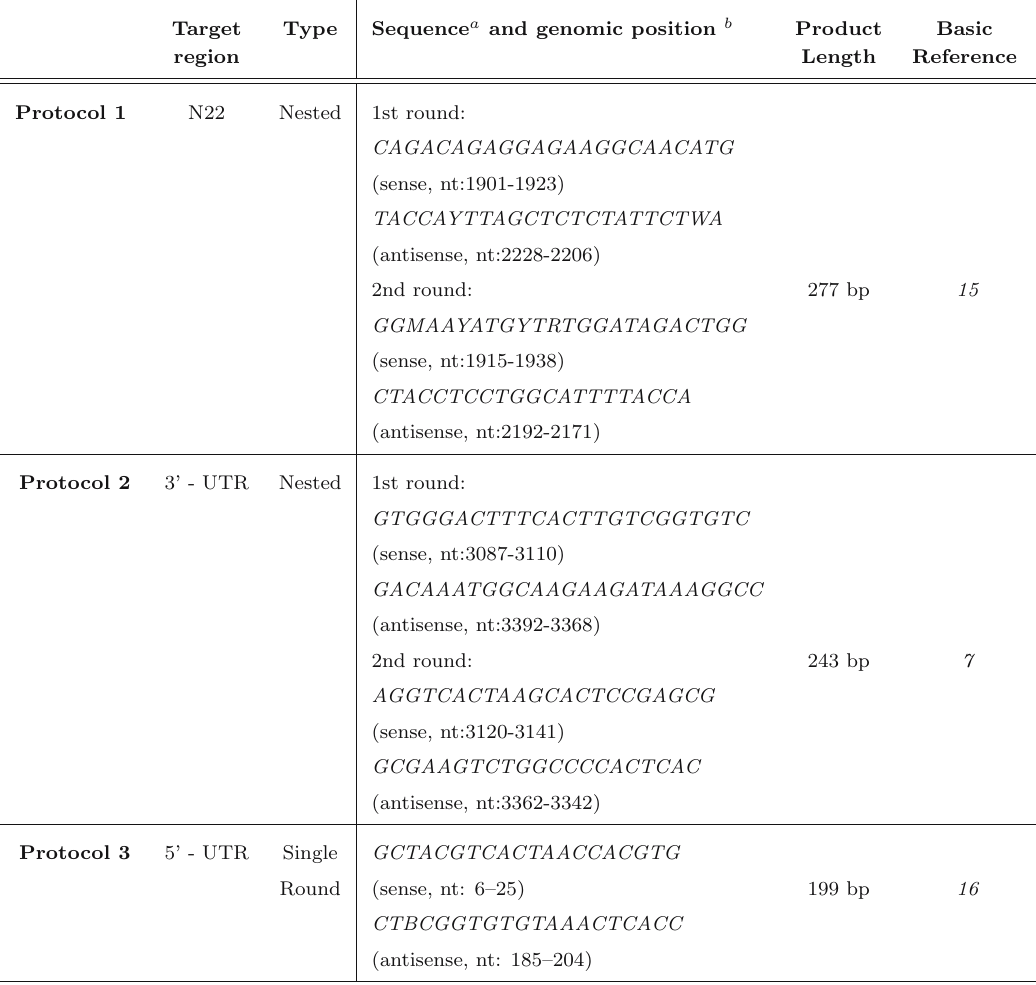
Table 1 Sequences, genomic positions and references of the primers used for the detection of TTV